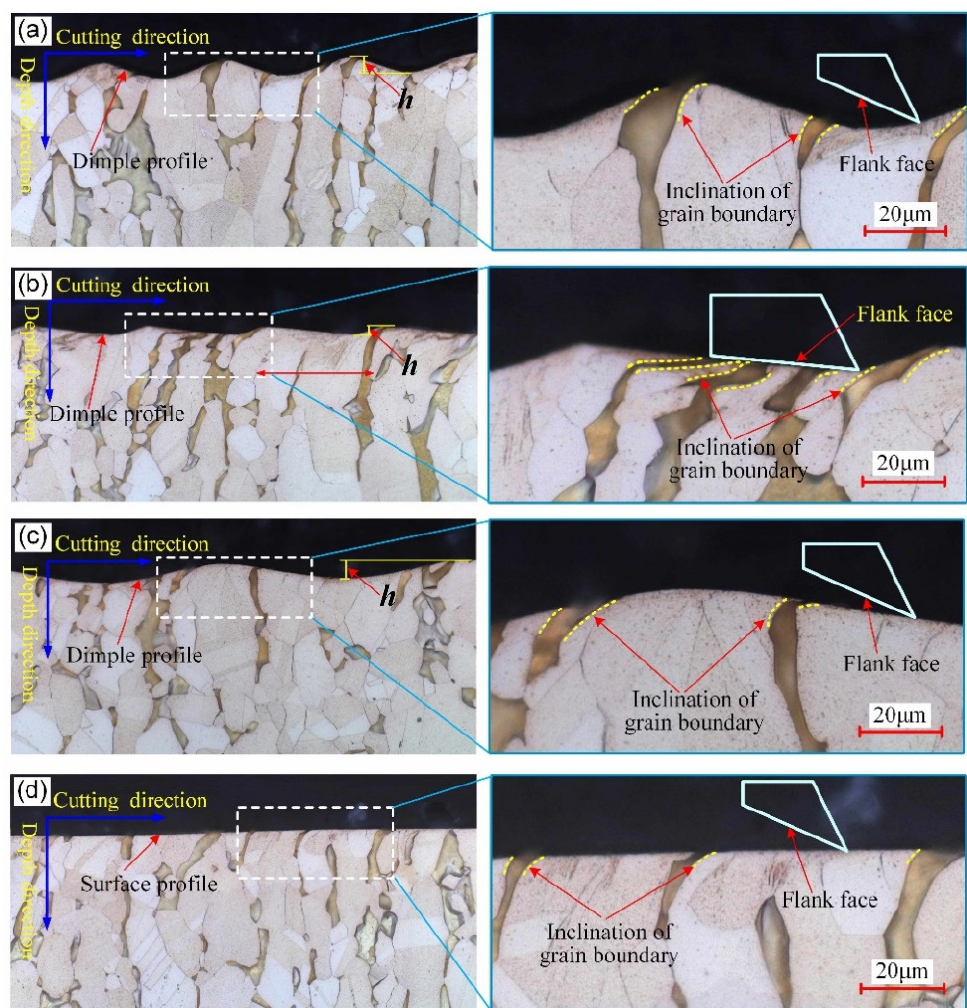
Figure 6. Subsurface microstructure of different surfaces: ( a ) surface #1; ( b ) surface #2; ( c ) surface #3; ( d ) surface #5.